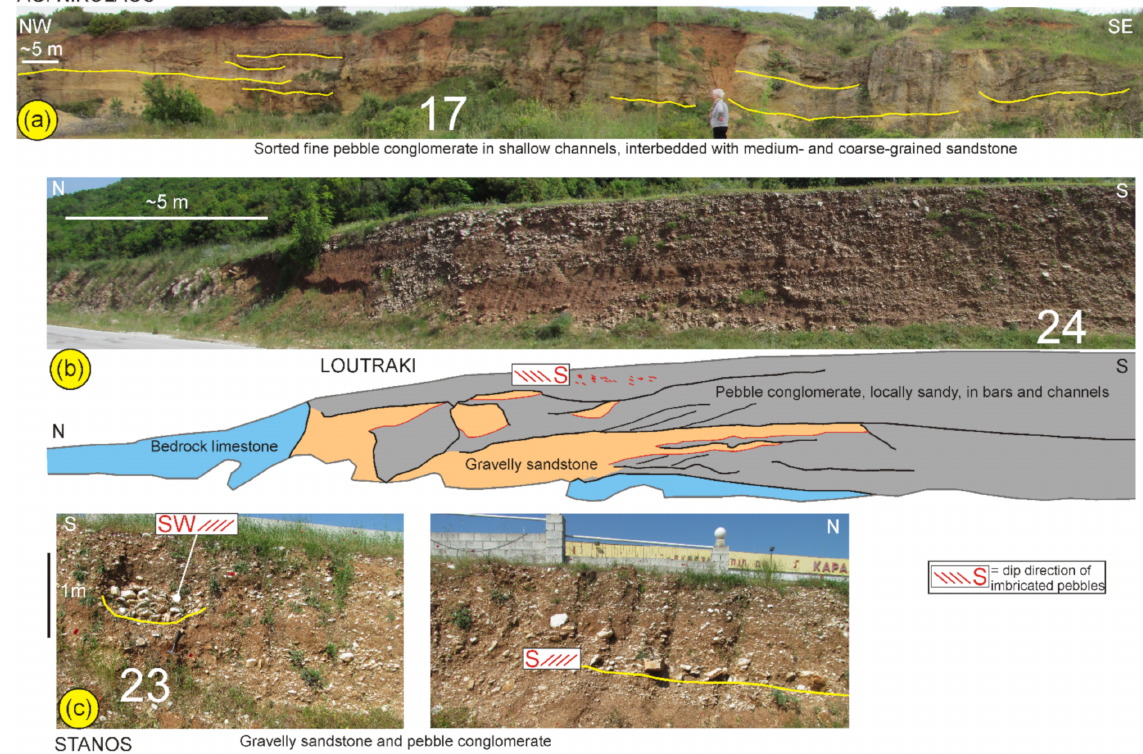
Figure 3. Field photographs and interpretative sketches of terrace gravels. ( a ) Ag. Nikolaos; ( b ) Loutraki; ( c ) Stanos. 17, 24, 23 are corresponding sample numbers, located in Figure 2. For interpretation, see text.